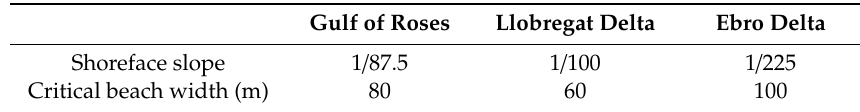
Table 2. Representative values to calculate coastal fringe re-adaptation to RSLR following Bruun rule for each study